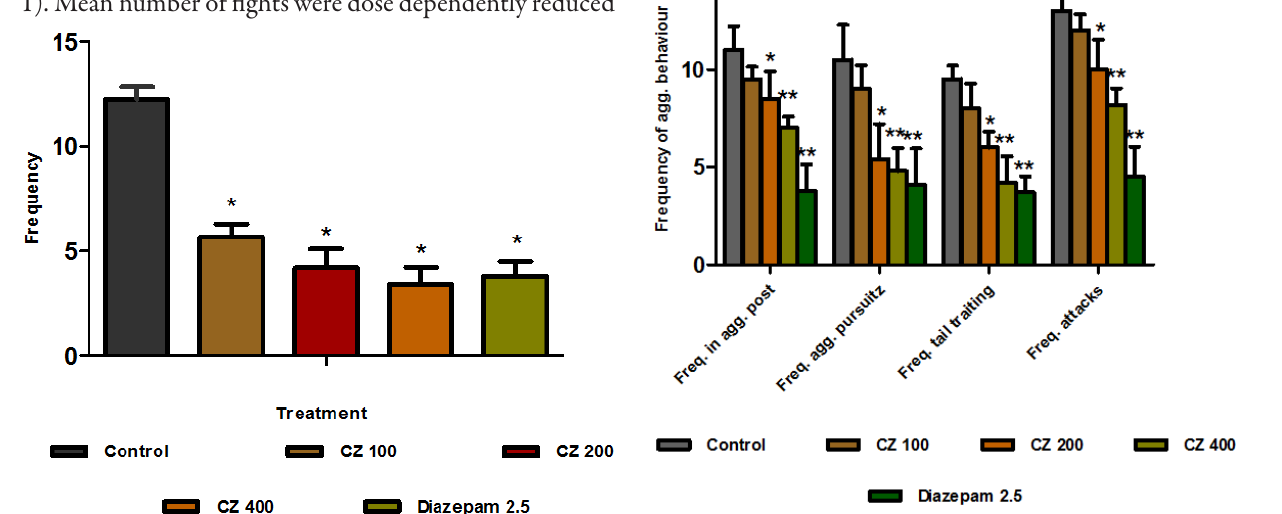
Fig. 1. Effect of EECZ on foot shock-induced aggressive behav- ior. Control = 6 and treatment extract n=6, * p <0.001 compared